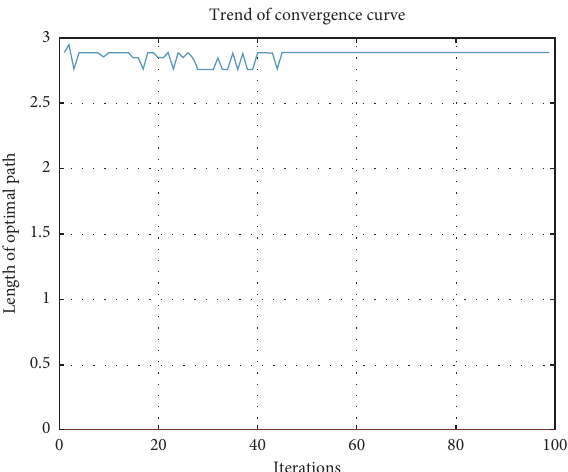
Figure 5: Te convergence curve of the improved ant colony algorithm.